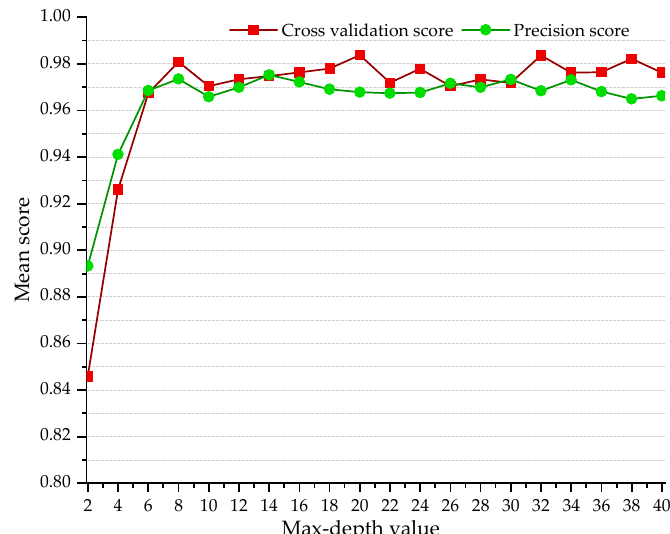
Figure 17. Mean score vs. max-depth.